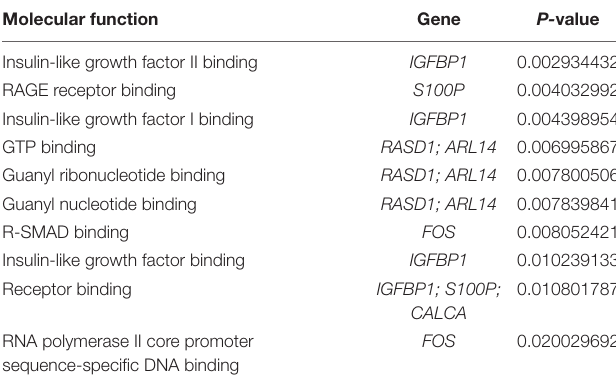
TABLE 3 | Gene ontology molecular function enrichment results.